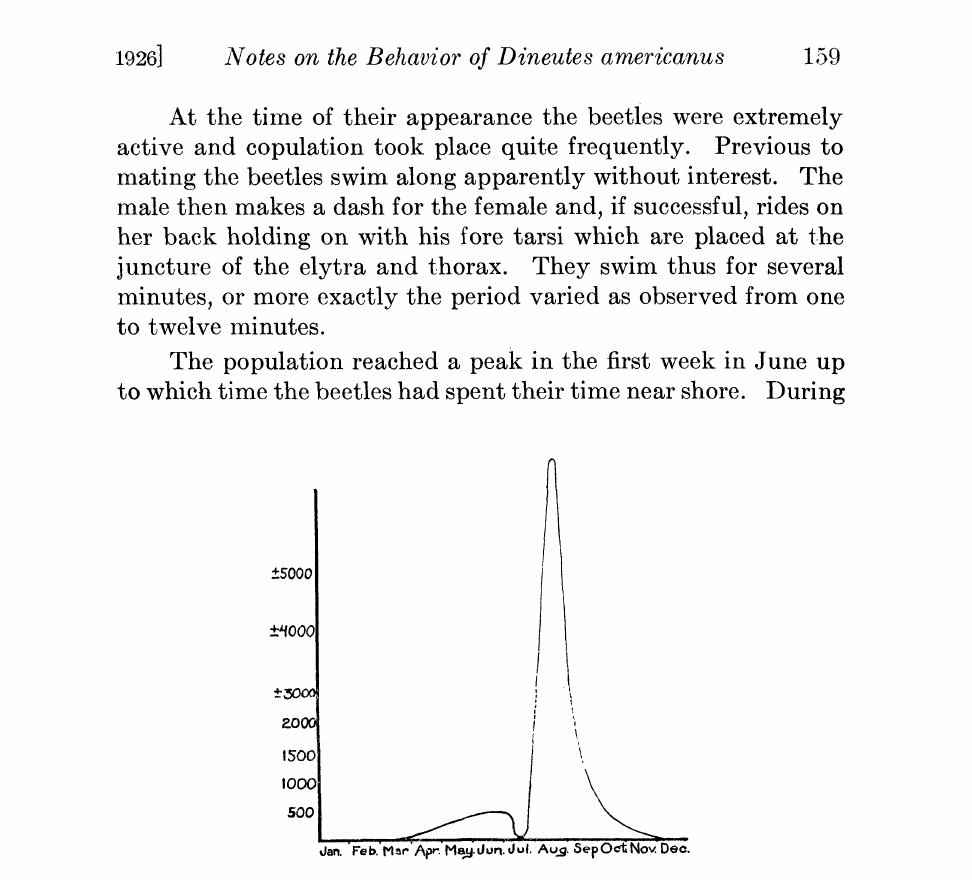
Fig. 1. Seasonal abundance of Dineutes americanus at Boston,